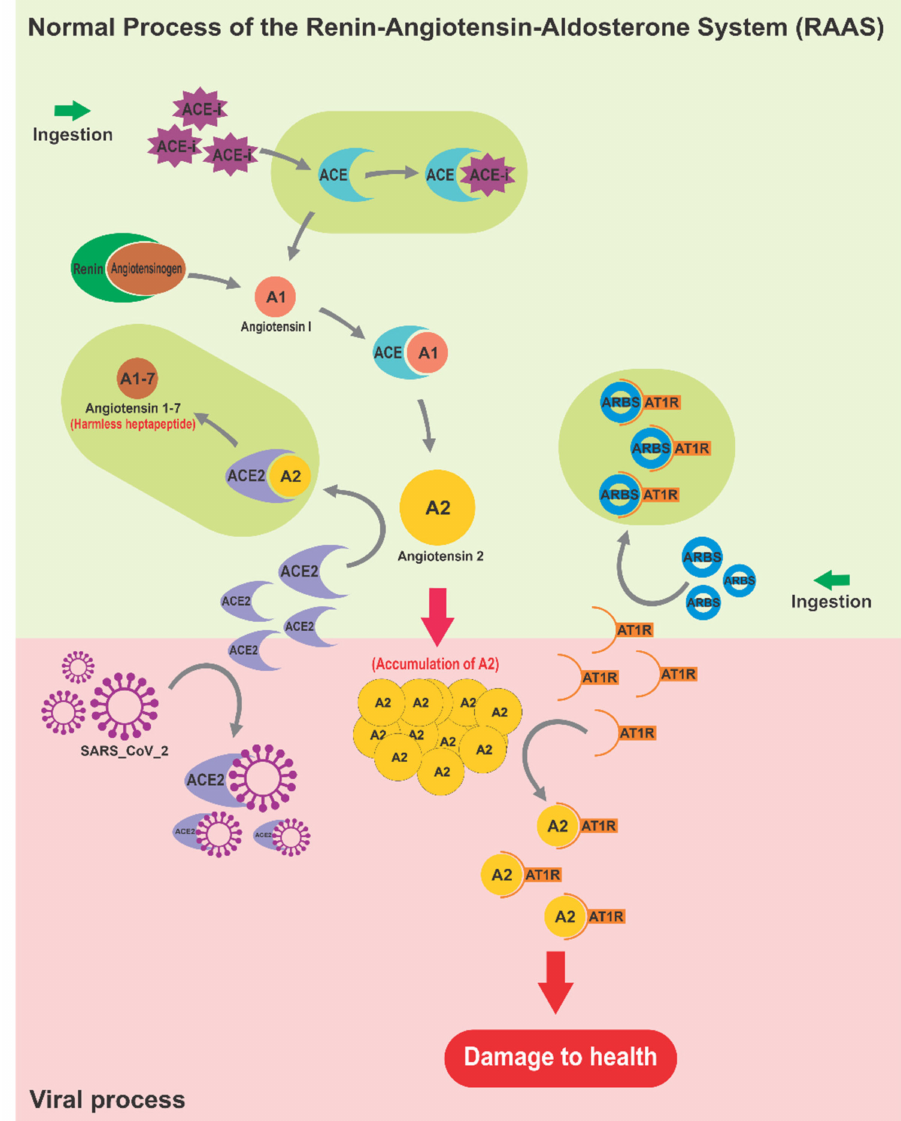
Figure 2. Mechanism of action of SARS-CoV-2 on the Renin–Angiotensin–Aldosterone System (RAAS) and its possible regulation by the Angiotensin converting enzyme inhibitors (ACEi), An- giotensin receptor blockers ARBs or Angiotensin converting enzyme (ACE2) that converts AI to A1-7 to restore the